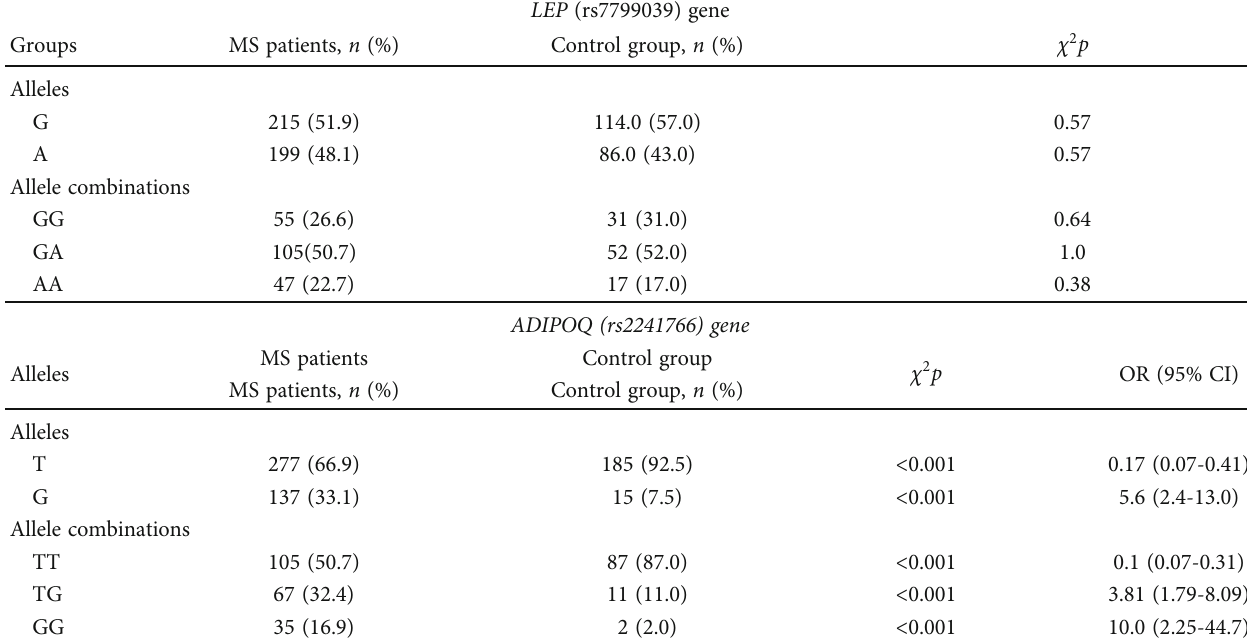
Table 2: Allele and genotype frequency distribution of LEP (rs7799039) and ADIPOQ (rs2241766) gene polymorphisms in patients with MS.